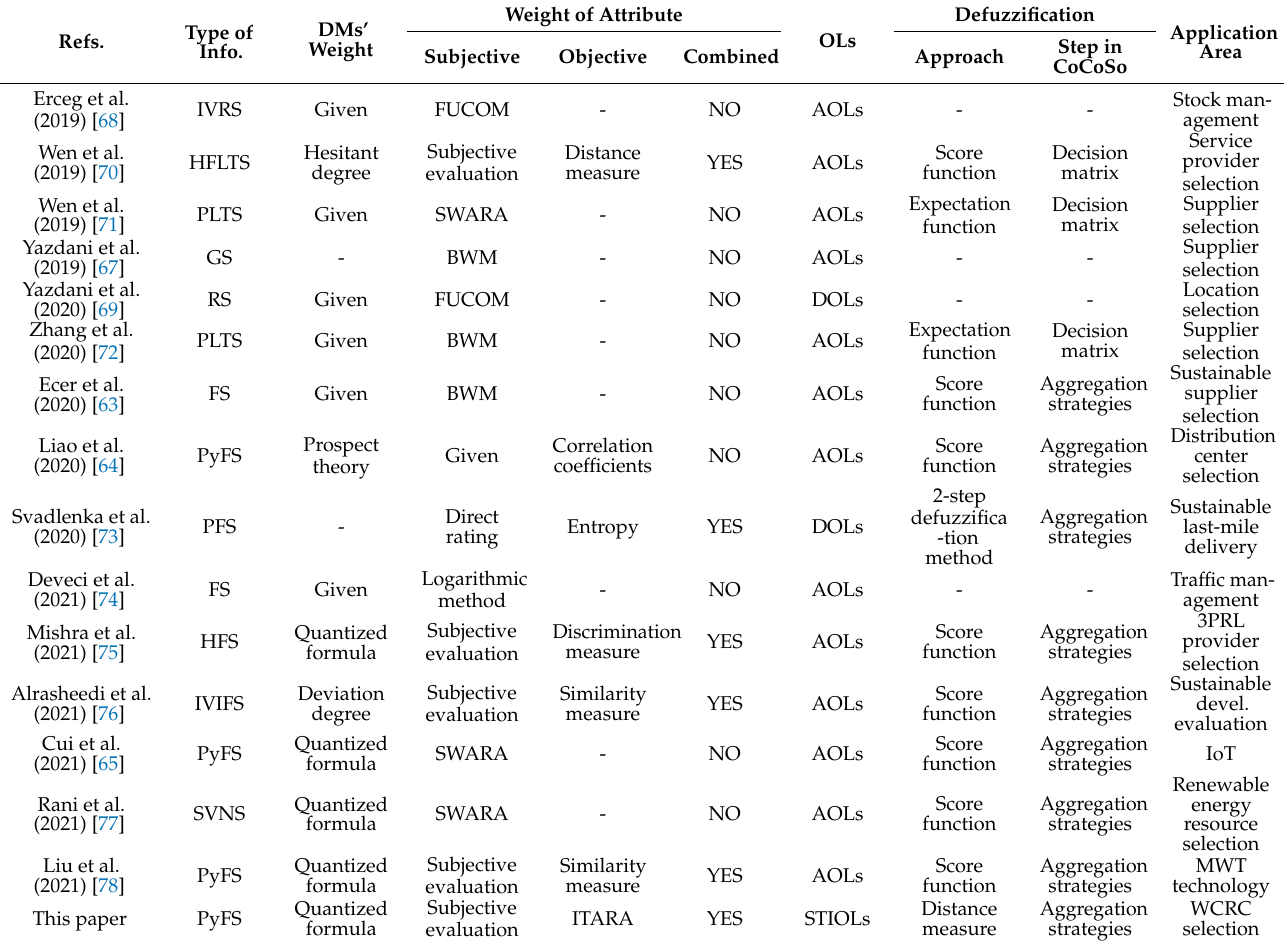
Table 1. Research status of existing CoCoSo methods for group decision making